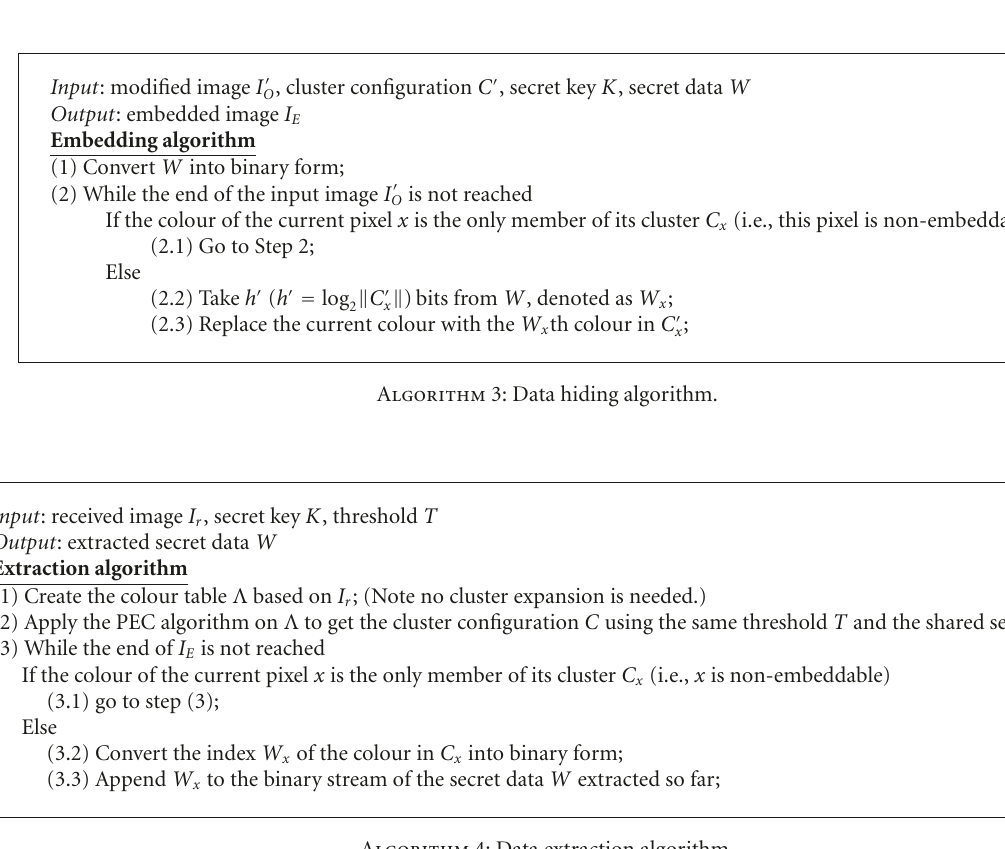
Algorithm 4: Data extraction algorithm.